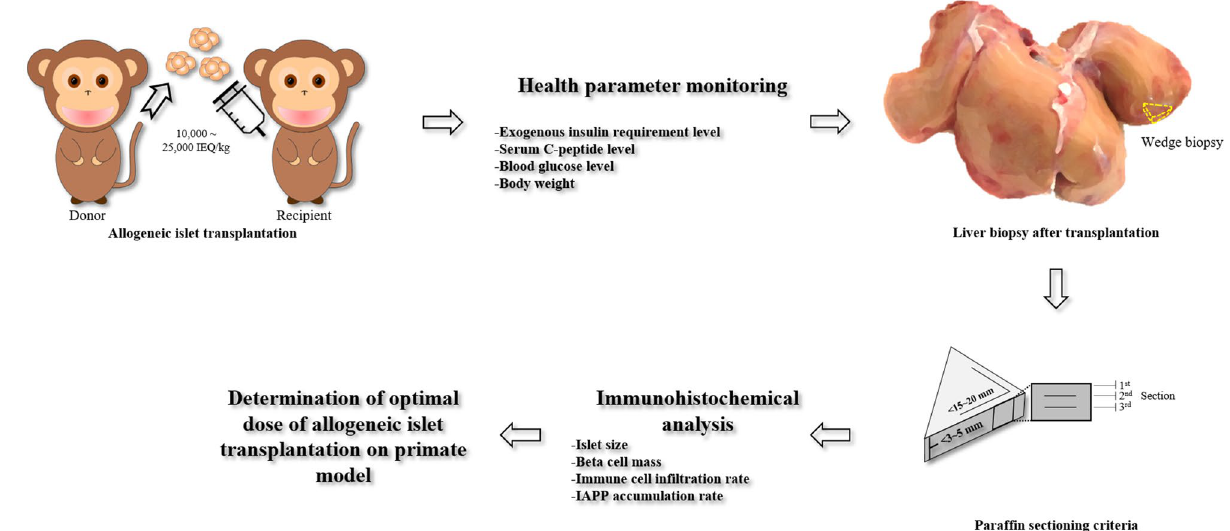
Figure 1. Scheme for allogeneic islet transplantation and liver biopsy process. Each diabetic recipient monkey received 10,000– > 25,000 IEQ/kg islets from a donor monkey. After transplantation, the health parameters of the recipient monkey were monitored, and a liver biopsy was conducted. The optimal dose of transplanted islets was determined after an analysis of the immunohistochemistry and insulin independence of each recipient